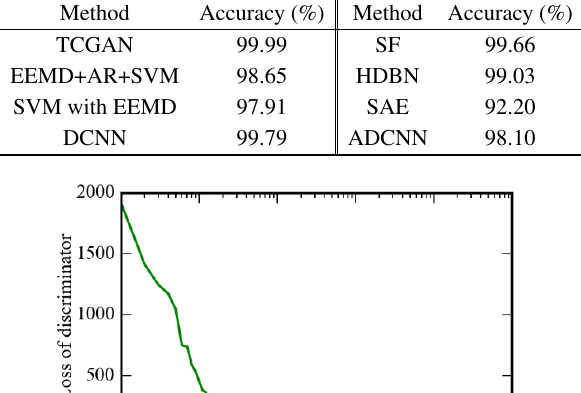
Table 2 Accuracy comparison results with other methods in Case 1.